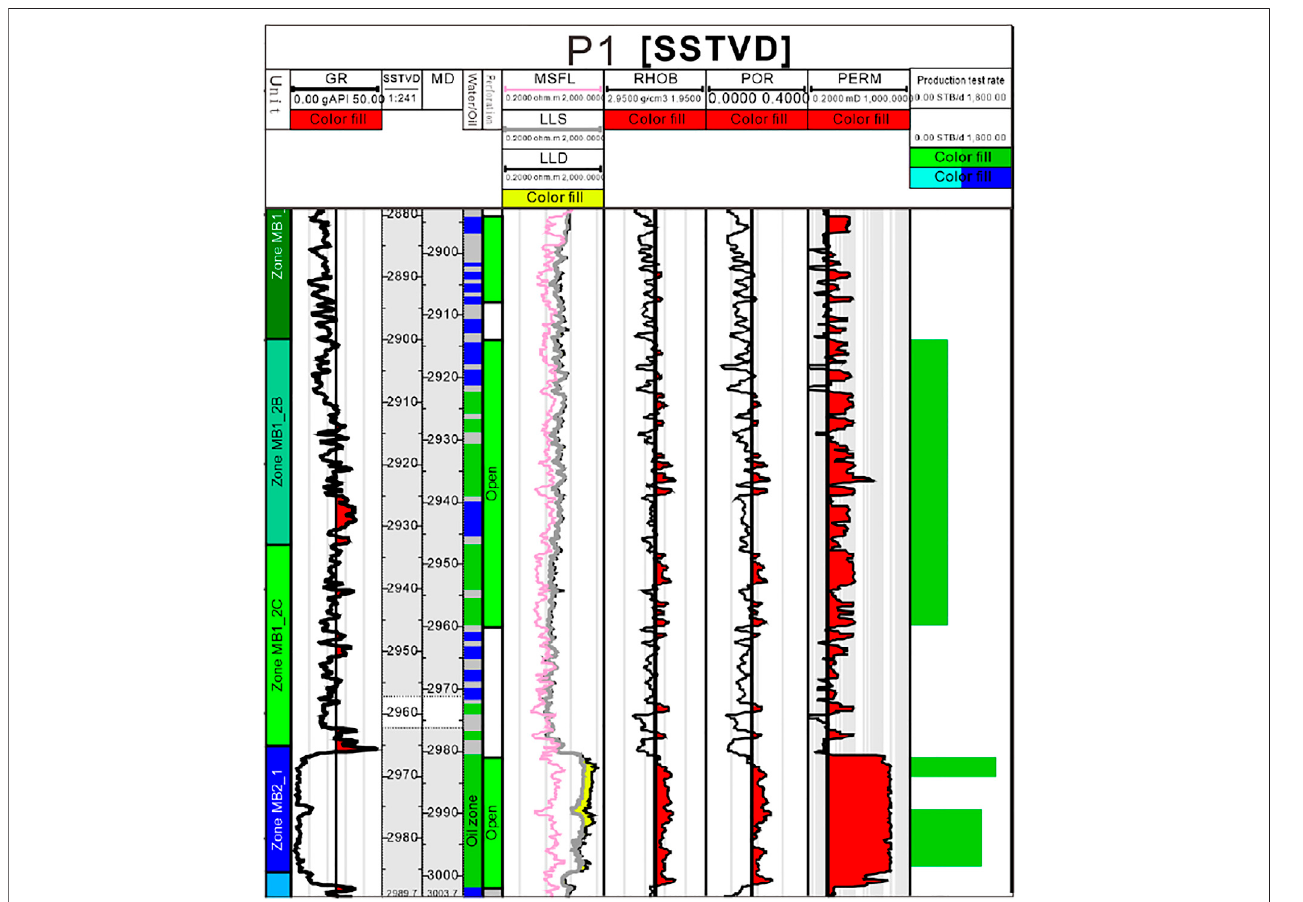
FIGURE 6 | Histogram of dynamic permeability calculation results of secondary splitting iteration of P1